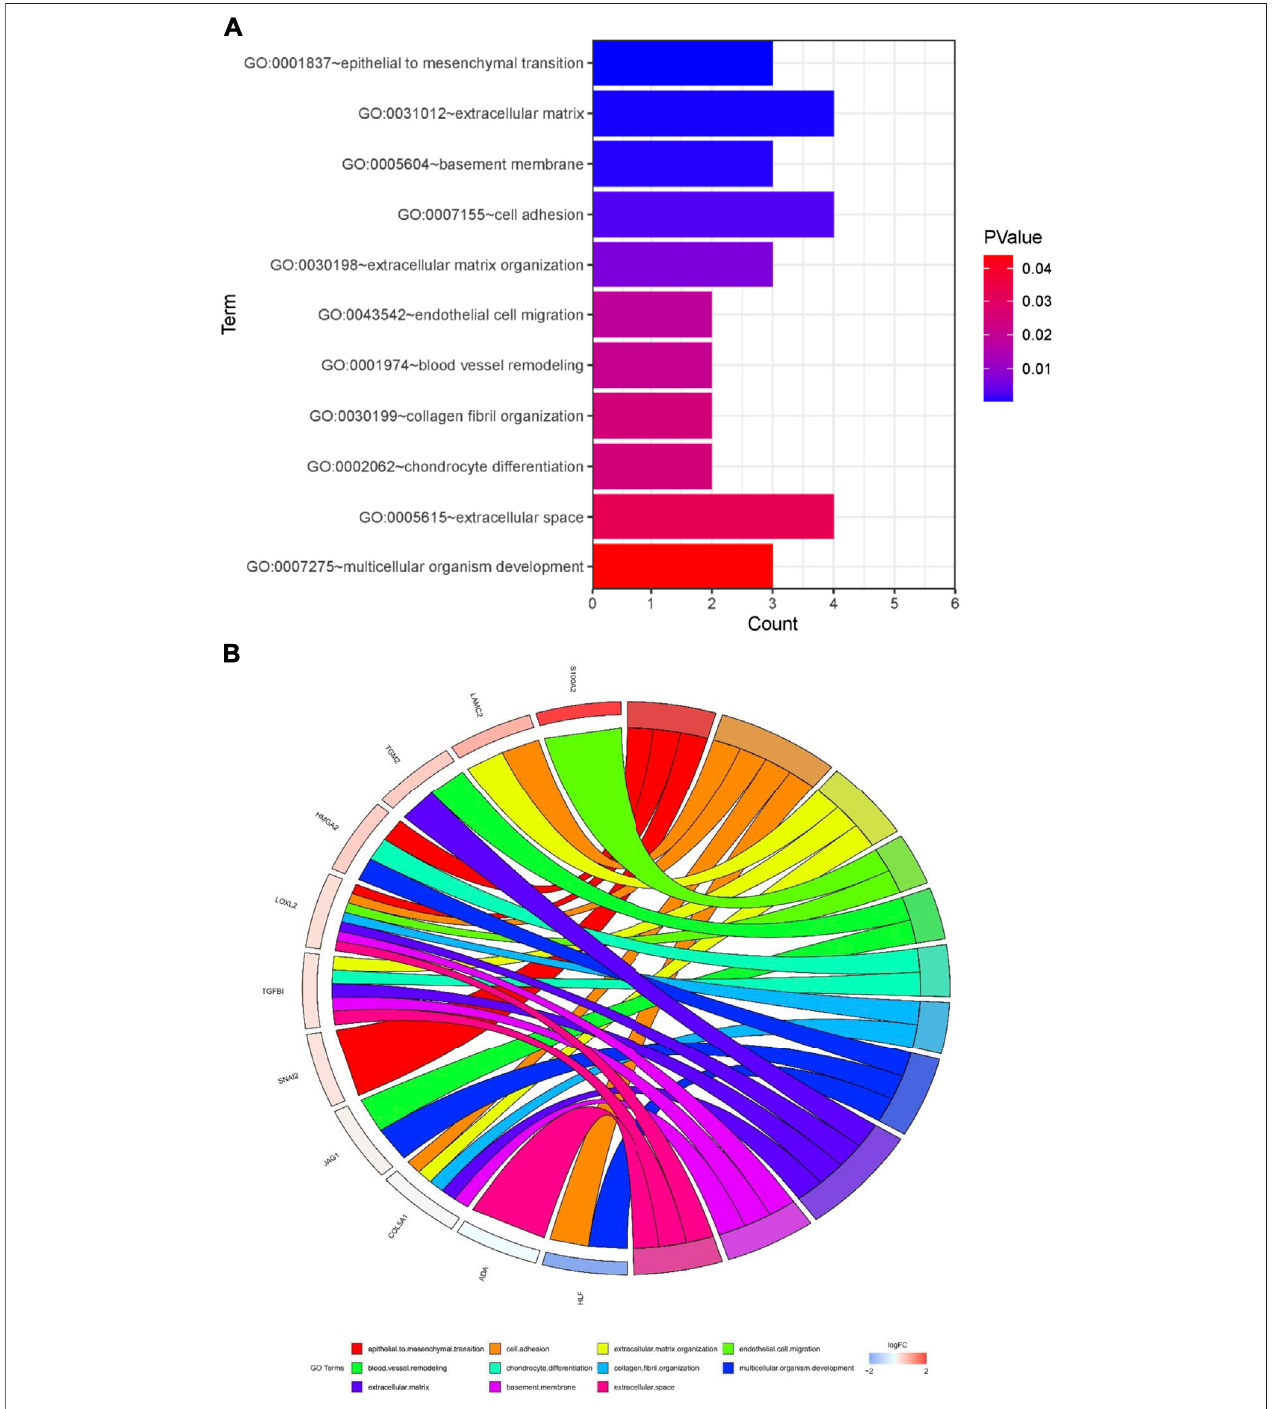
FIGURE 5 | Potential mechanisms associated with tumor metastasis (A) GO enrichment analysis of overlapping differentially expressed genes (DEGs) (B) Gene Ontology(GO)analysisof13epithelial-mesenchymaltransitionrelatedgenes.Analysesareshowninachordplot,inwhichtheleftsiderepresentsthe13selectedgenes, and the right side shows the GO enrichment pathway ofthe selected genes. Genes were ranked from large to small according to the change of logFC expression in the sample. The upper side represent up-regulated genes, and the lower side depicts down-regulated genes.Differentcolorsrepresent differentclustersin GO terms.